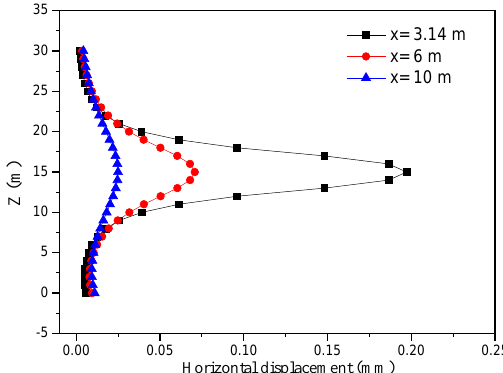
X dA Figure 7. Integral region of q. As shown in Figure 8, under the action of additional thrust q , ground uplifts in front of the cutter head, settlements behind the cutter head. Both reach maximum at 1 D and tend to be stable at 4.5 D away from the cutter head. The displacement is small by and large, for each 50 kPa increase in q , the maximum displacement increases by 0.025 mm. Figure 9 shows that the horizontal displacement caused by q of the cutter head mainly appears within the depth of 1.5 D when Y = 1.